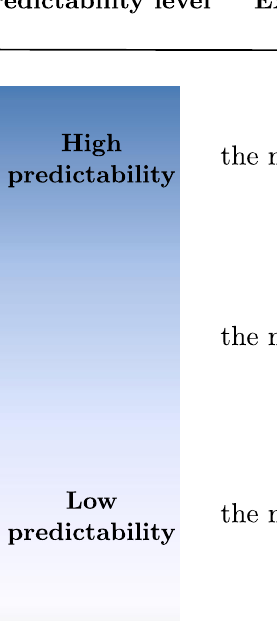
Figure 1. Schematic representation of the alleged gradient of cerebellar activation as a function of the language-based predictability. In particular, for the language domain, we expect cerebellar activation to be related to the predictability of the sentence, with higher activation for more predictable words.